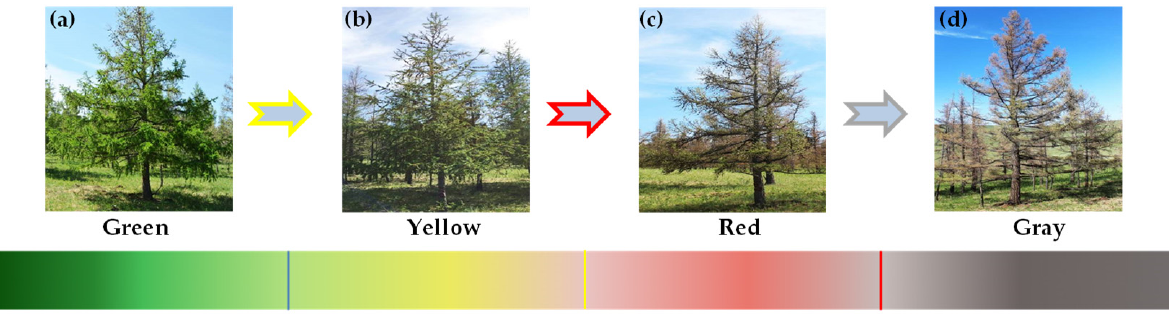
Figure 2. Stages of larch canopy: ( a ) Green ( b ) Yellow ( c ) Red ( d ) Gray. Table 1. Sample tree evaluation table.